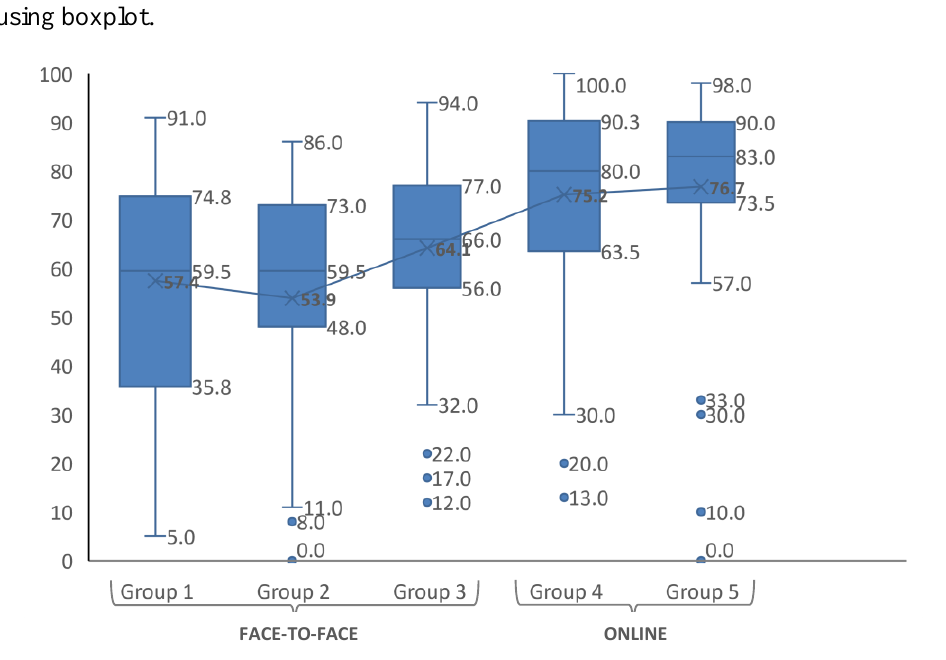
Figure 1. Distribution of score points for each group